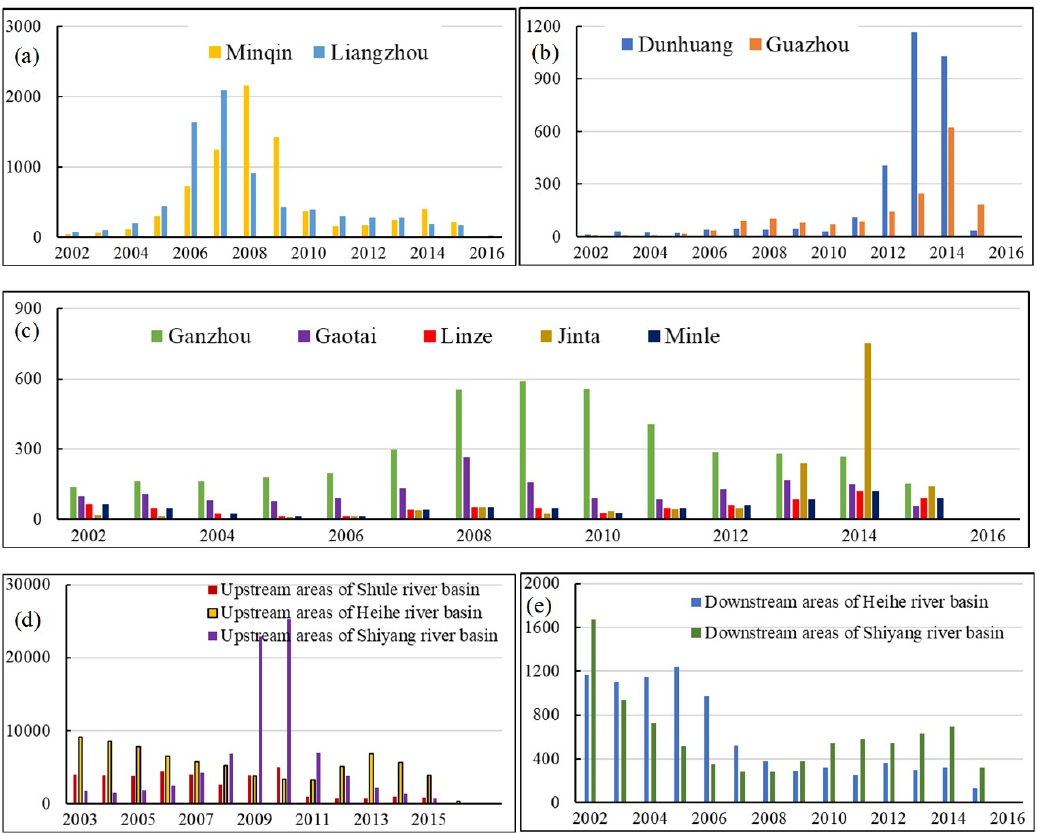
Figure 10. The statistics on the time that NDVI began to decrease in different counties of Wuwei Prefecture ( a ), Jiuquan Prefecture ( b ), and Zhangye Prefecture ( c ); and the statistics on time that vegetation conditions began to improve in the upstream areas ( d ) and the downstream areas ( e ) of the river basins. Values in the Y axes of each histogram were the number of pixels in each individual year. Only the pixels where vegetation changes were driven by the factors associated with human activities (Figure 9) were counted in the histograms.